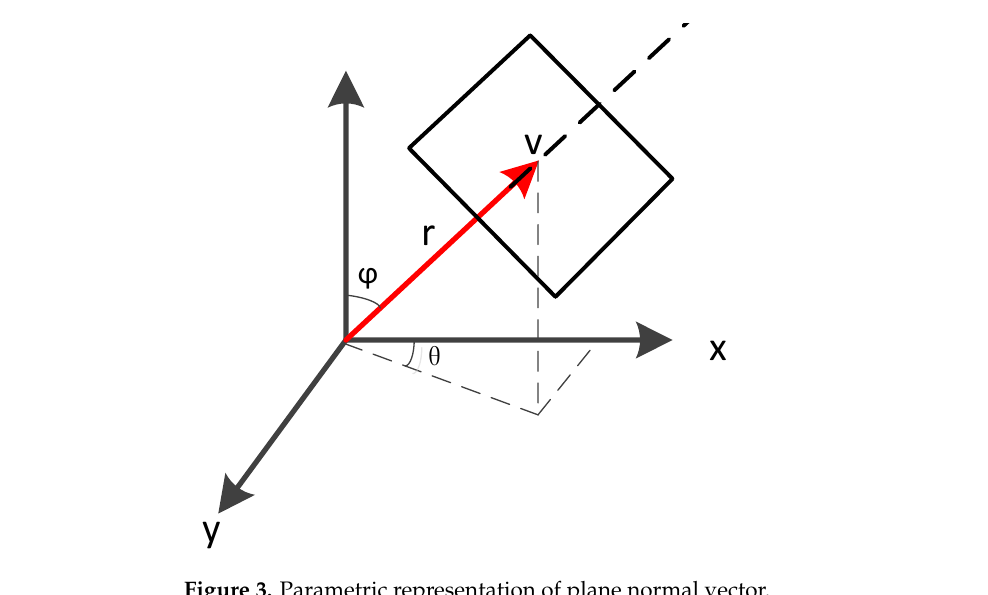
Figure 3. Parametric representation of plane normal vector.